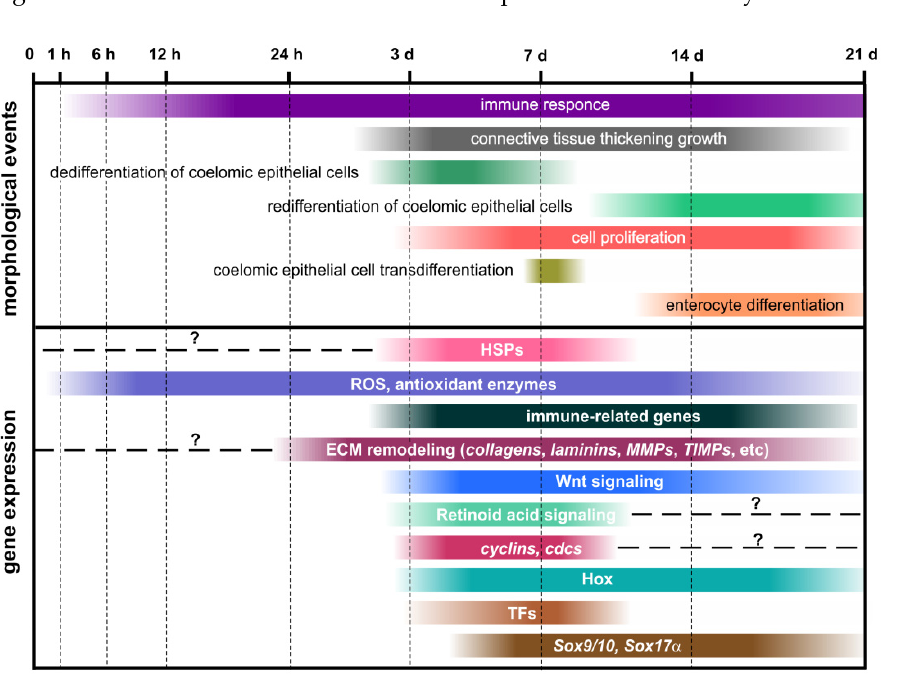
Figure 5. Schematic representation of morphological and molecular events during visceral regen- eration after anterior evisceration. Timeline is represented by hours and days of regeneration after evisceration. Horizontal dotted line means no data.